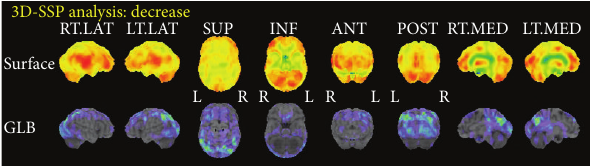
Figure 9: Three-dimensional stereotactic surface projections (3D- SSP) of single-photon emission computed tomography with N- isopropyl[ 123 I]-p-iodoamphetamine (IMP-SPECT) of the patient in Case C. Decreased perfusion in the bilateral parietal cortex, precuneus, and posterior cingulate cortex indicated comorbid Alzheimer’s